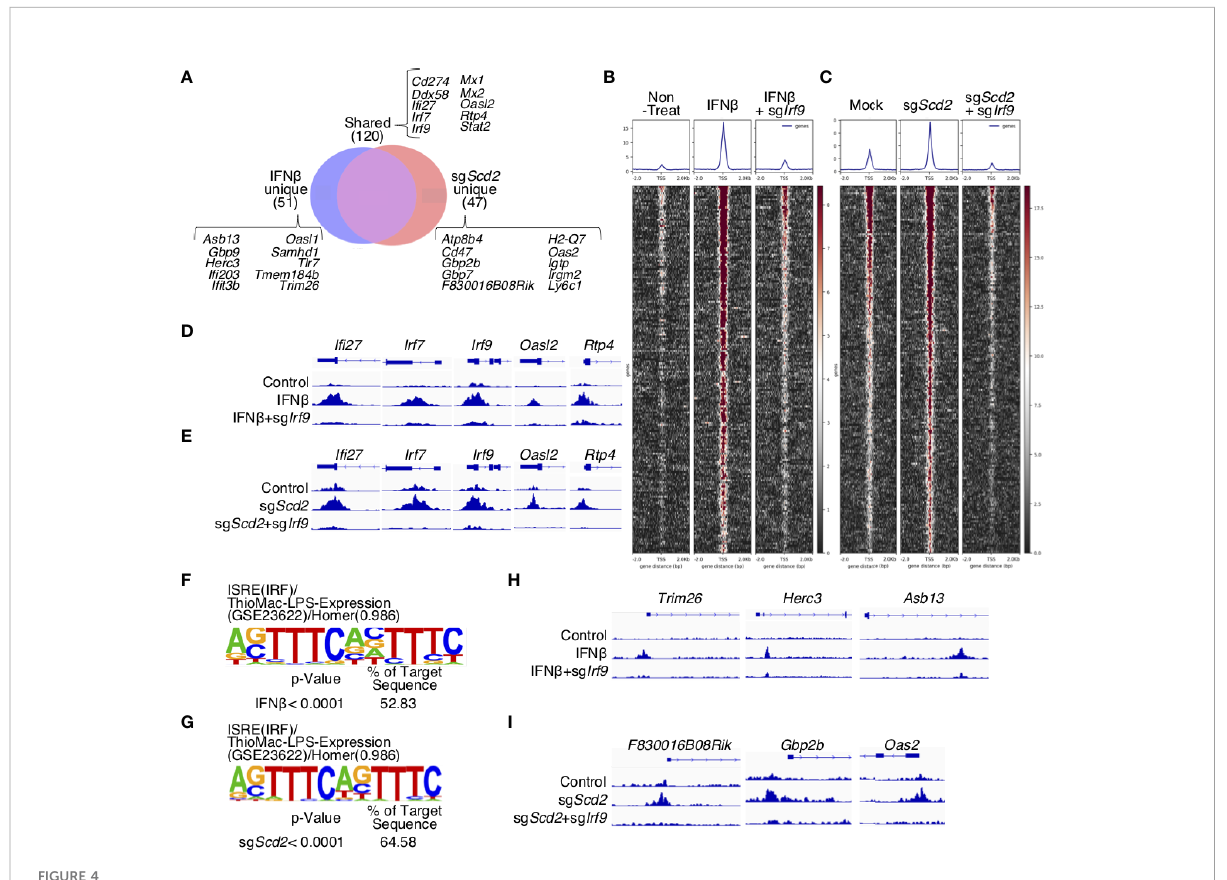
FIGURE 4 IRF9 in sgScd2 Th1 cells bound to a region that was not bound by IFN b -treated Th1 cells. (A) Venn diagrams showing the peak count for IRF9 ChIP-seq. Peaks were divided into IFN b -unique, shared and sgScd2-unique sections. (B, C) Heatmaps and average aggregate plots were generated using deeptools plotHeatmap and plotPro fi le in non-treat, IFN b and IFN b -treated sgIrf9 (B) , or mock, sgScd2 and sgScd2/sgIrf9 Th1 cells (C) . TSS from 2kb upstream of the transcriptional start site to -2 kb downstream was analyzed. (D, E) Example of shared IRF9 binding sites at the genomic region for I fi 27, Irf7, Irf9, Oasl2 and Rtp4 in non-treat, IFN b and IFN b -treated sgIrf9 (D) or mock, sgScd2 and sgScd2/sgIrf9 Th1 cells (E) . The arrow indicates the direction of transcription. (F, G) Results of the HOMER de novo motif analysis from IFN b -unique peaks (F) or sgScd2-unique peaks (G) relevant to (A) . (H, I) Example of IRF9 binding sites at the genomic region for Trim26, Herc3 and Asb13 in IFN b -unique peaks (H) and F830016B08Rik, Gbp2b and Oas2 in sgScd2-unique peaks (I)